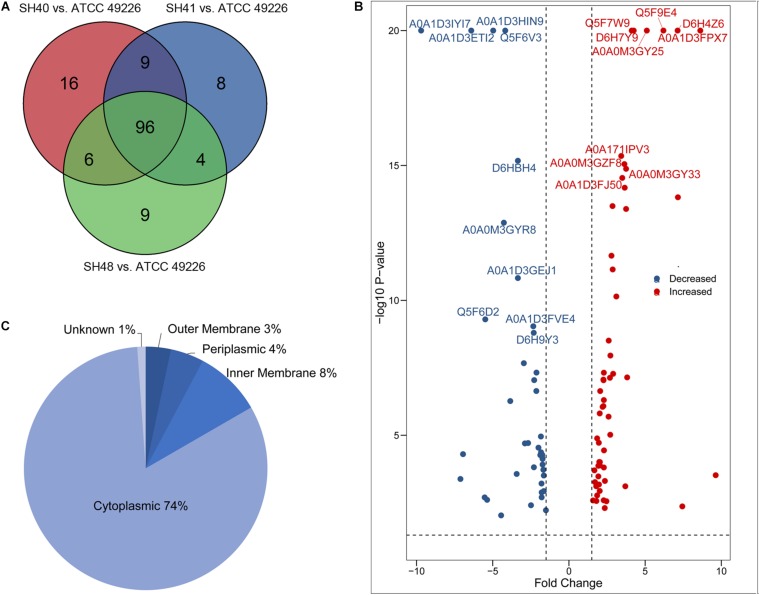
Proteome profiling in Neisseria gonorrhoeae ATCC49226 and three ESC-resistant N. gonorrhoeae clinical isolates. (A) Venn diagrams illustrating the distribution of differentially expressed proteins of 3 clinical isolates compared to the reference strain ATCC49226. Ninety-six differentially expressed proteins common to the 3 clinical isolates were revealed, while a total of 127, 117, and 115 differentially expressed proteins were identified in N. gonorrhoeae isolate SH40, SH41 and SH48, respectively. (B) Volcano plot of protein abundance differences. The top 10 significantly differentially expressed proteins with lowest P value were showed. (C) Predicted cellular localizations of 96 differentially expressed proteins.